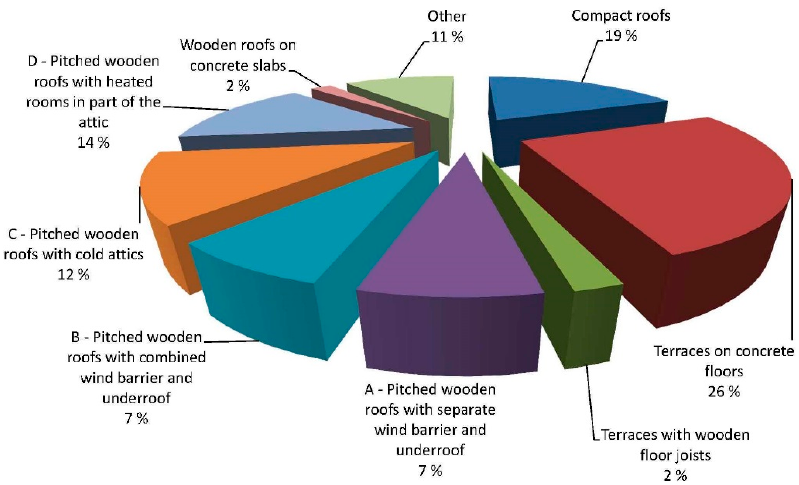
Figure 6. Defect cases for the 10-year period from 1993–2002 concerning roofs, distributed by type of roof (465 cases, 22% of the total amount of building defects) [12].